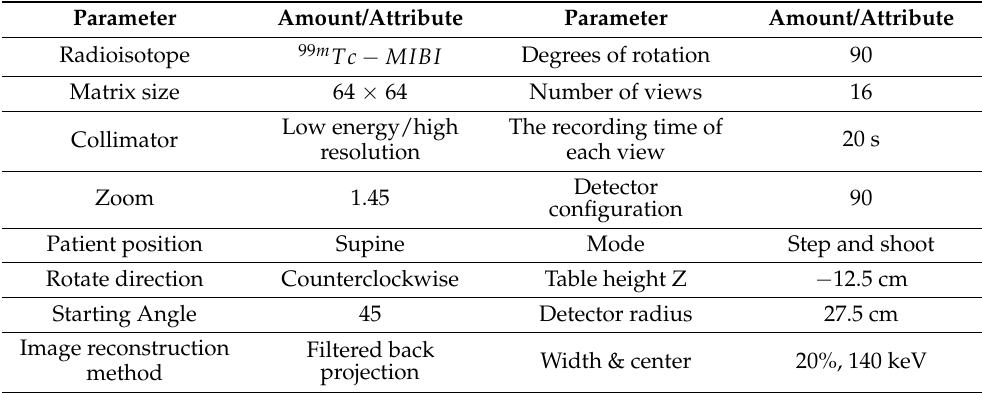
Table 2. Characteristics of myocardial perfusion SPECT images.